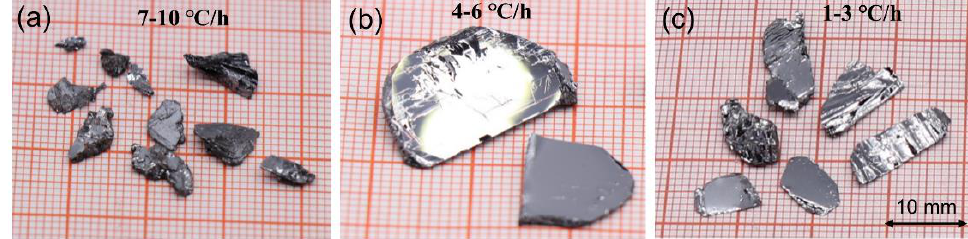
Figure 1. GeP crystals grown by Bi flux method at a cooling rate of ( a ) 7 – 10, ( b ) 4 – 6 and ( c ) 1 – 3 °C/h. Each small square in all images is 1 mm 2 .